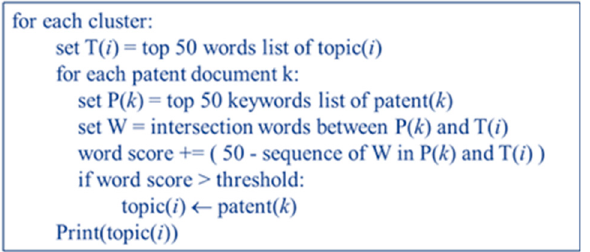
Figure 9. Algorithm of topic modeling and patent topic assignment.